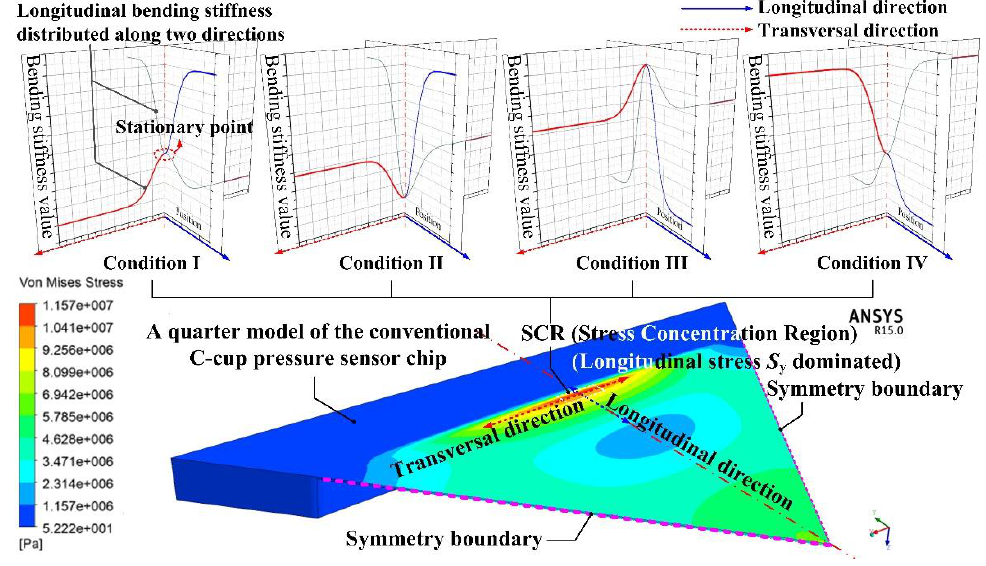
Figure 1. Stiffness distributions along two main directions around SCR of a pressure sensing chip.